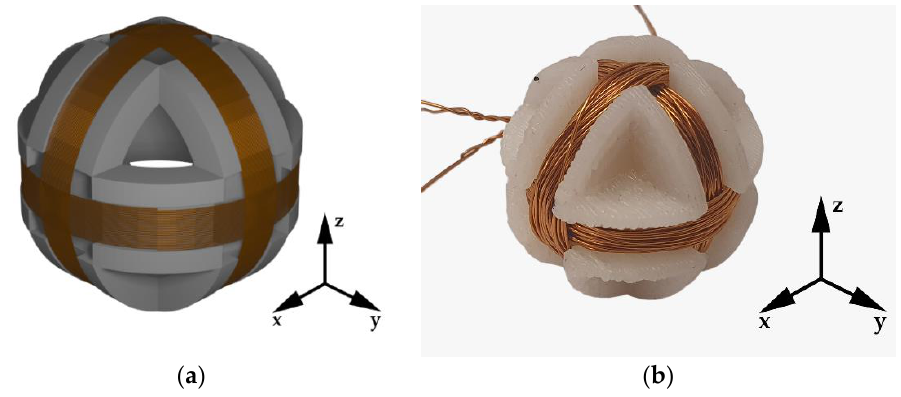
Figure 14. 3D search coil: ( a ) 3D model; ( b ) Fabricated 3D search coil.